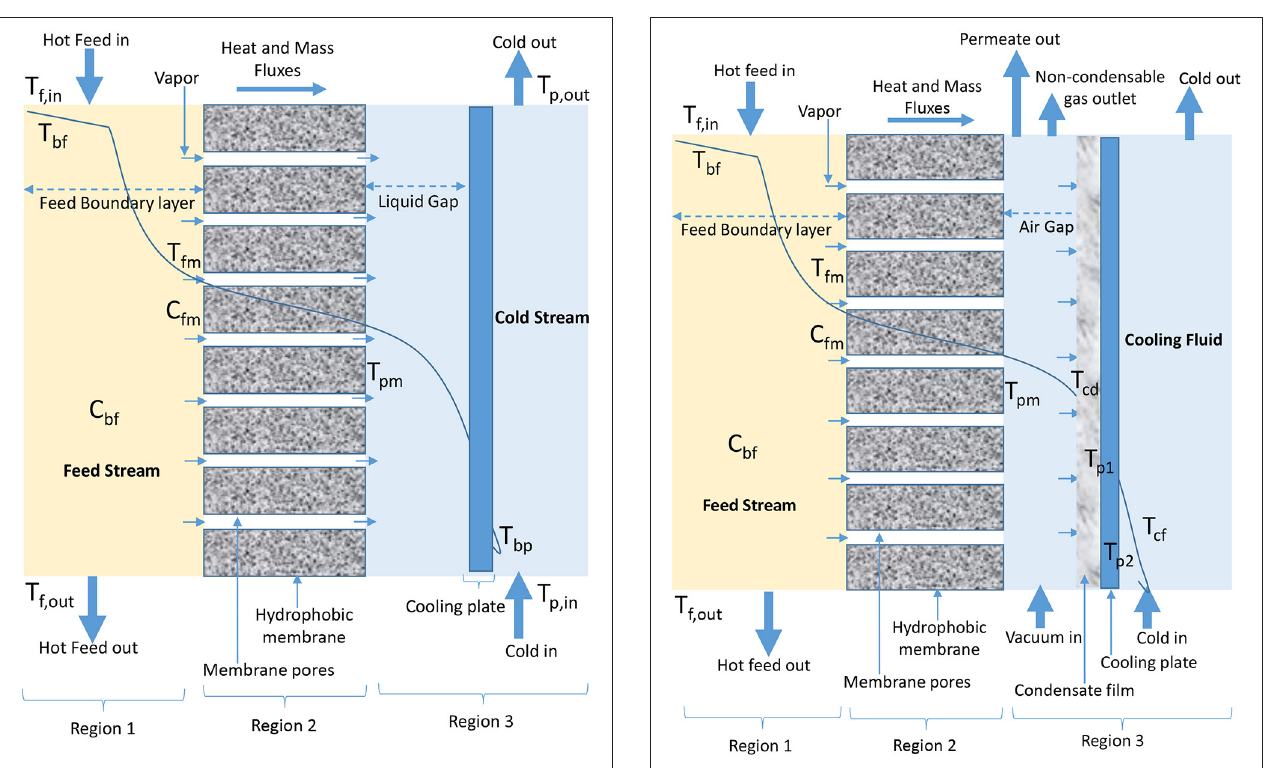
FIGURE 7 | Heat and mass transfer in VA-AGMD